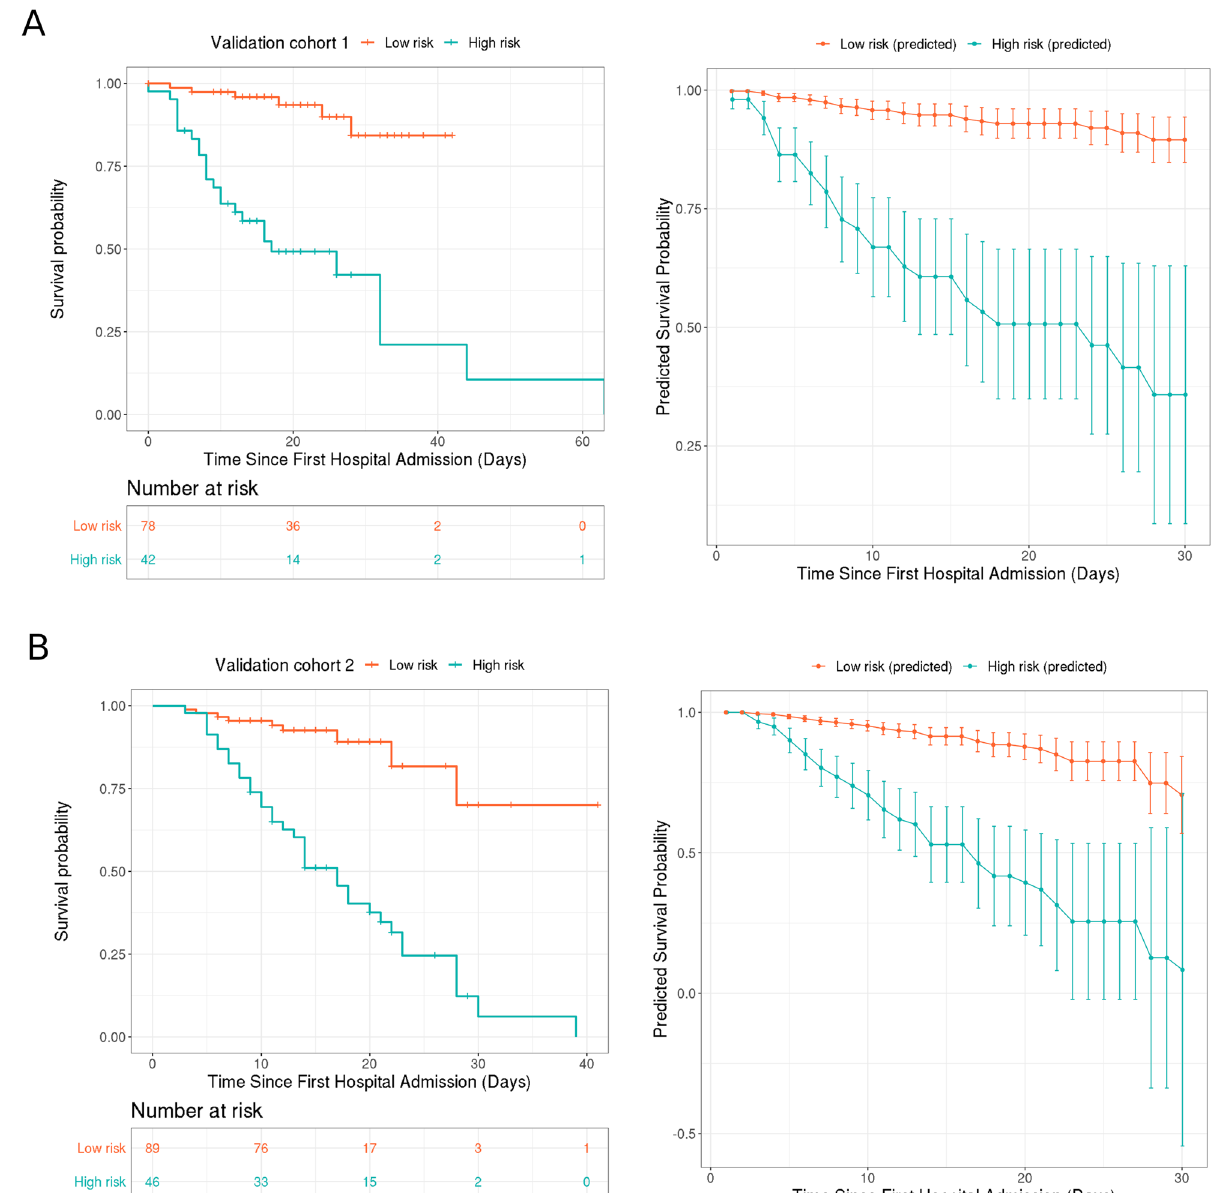
Figure 2. Prognostic model achieves clinical stratification and predicts overall survival (OS) in two validation cohorts. ( A ) Survival probabilities in the low- and high-risk subgroups defined by the consistent cutoff of 799 in the validation cohort 1 (RHWU + WNH) (left), correspondingly predicted survival probabilities in this cohort (right). ( B ) Survival probabilities in the low- and high-risk subgroups defined by the same cutoff in the validation cohort 2 (WPH) (left), correspondingly predicted survival probability in this cohort (right) (this figure is produced using R 3.6 37